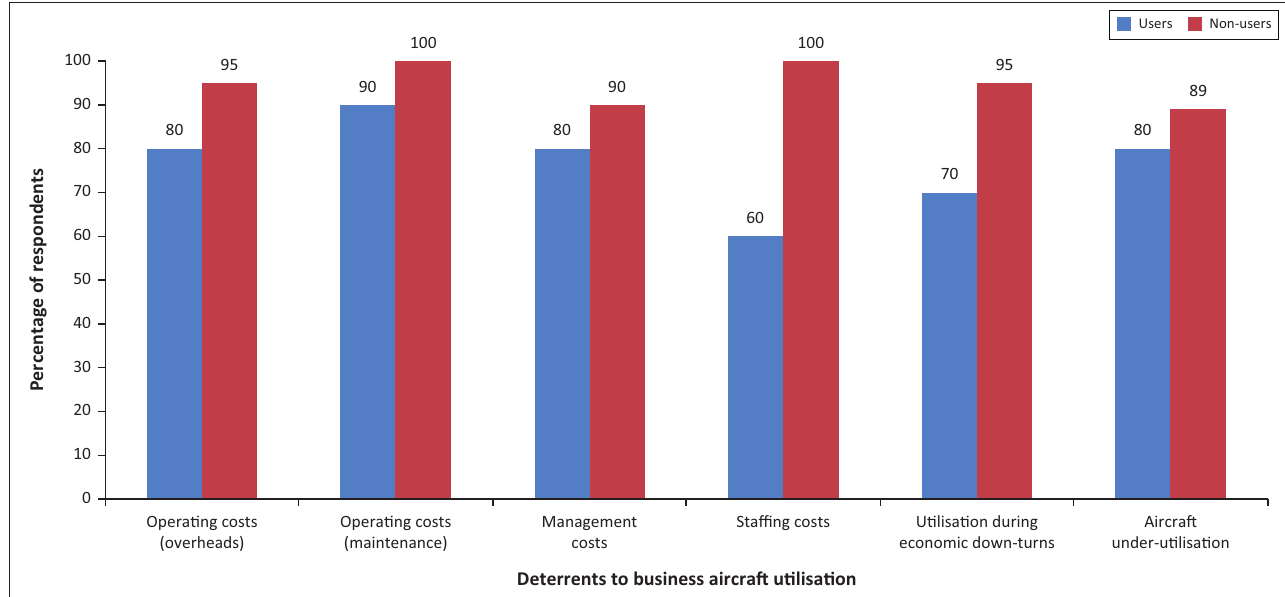
FIGURE 4: Comparison of business aircraft users and non-users regarding deterrents to utilisation ( n = 11 users; n = 19 non-users).